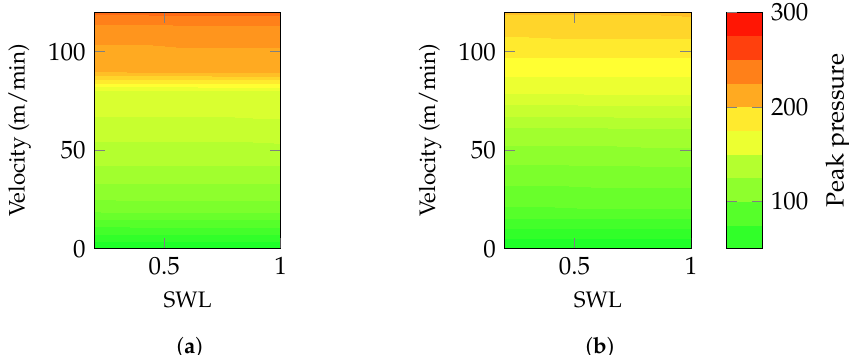
Figure 8. Maximum peak pressure during test sequence: ( a ) Classic; ( b )